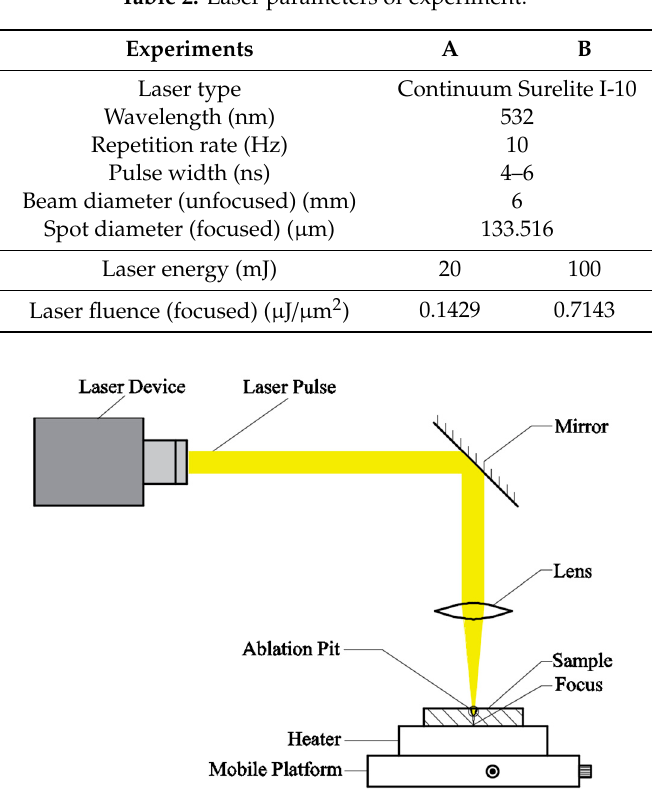
Figure 1. Schematic diagram of the ablation experiment.